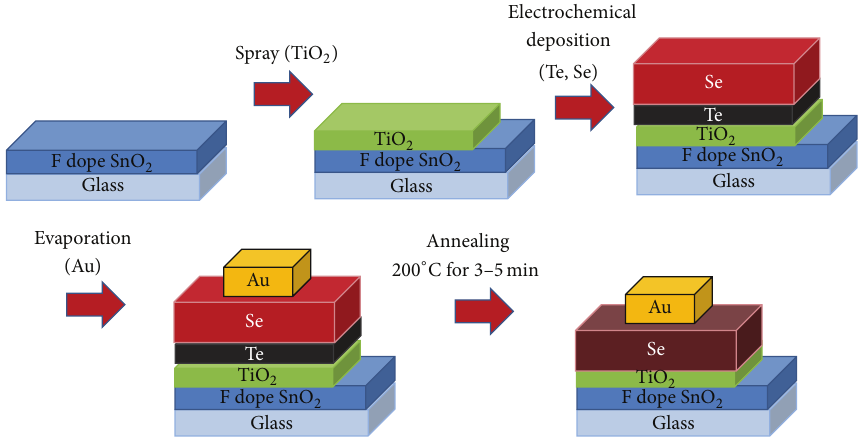
Figure 1: Fabrication scheme of electrodeposited Se-Te solar cells.